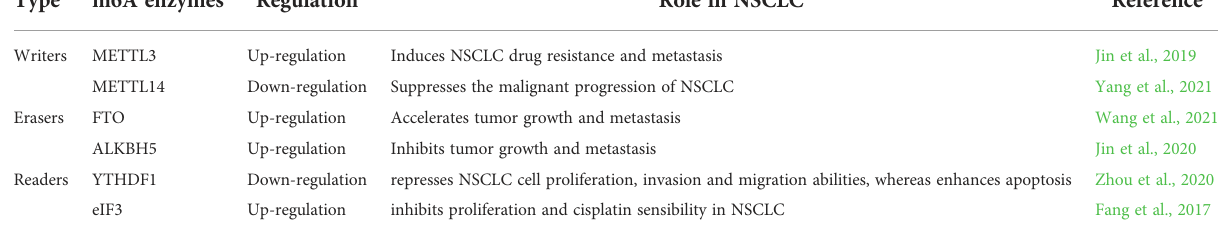
TABLE 1 The roles of m6A enzymes in NSCLC progression.